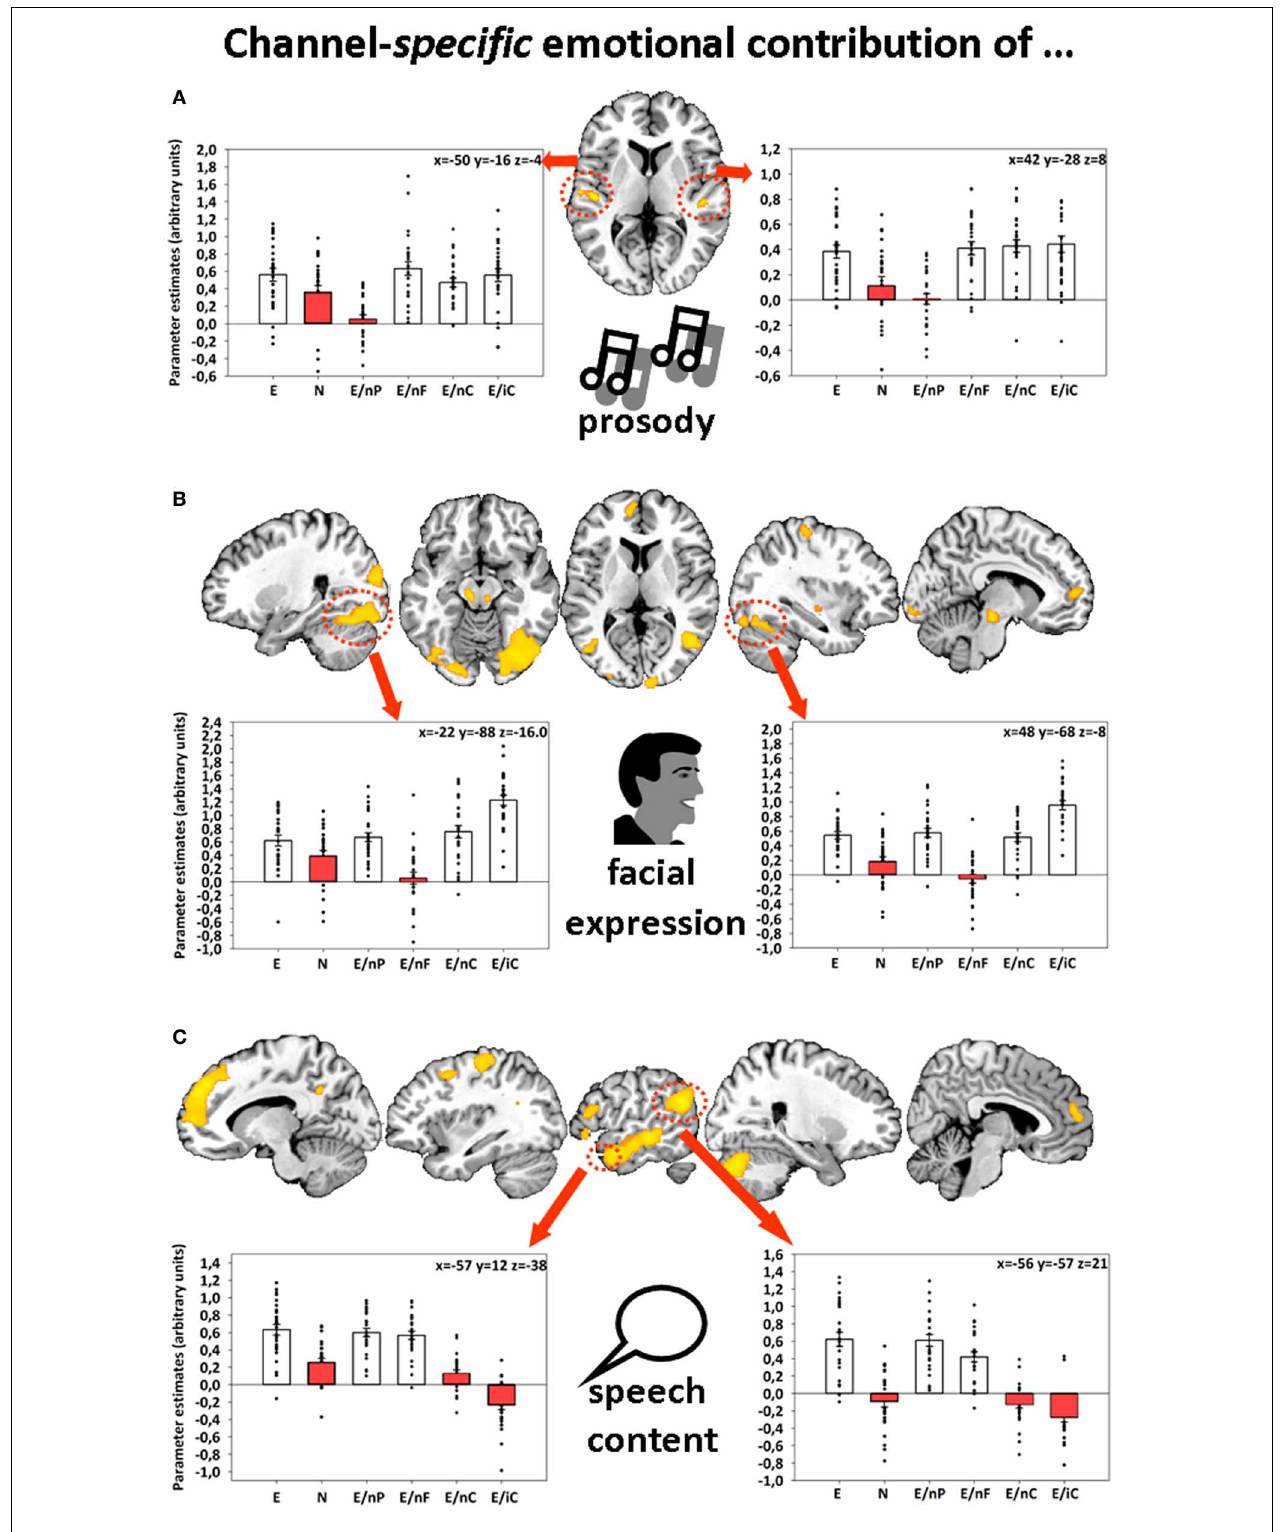
FIGURE 1 | Sliced MNI brain templates and overlays comprising the group activations of (A) emotional prosody, (B) emotional facial expression, and (C) emotional speech content. Within several activated clusters (indicated by red dotted shapes), individuals’ parameter estimates